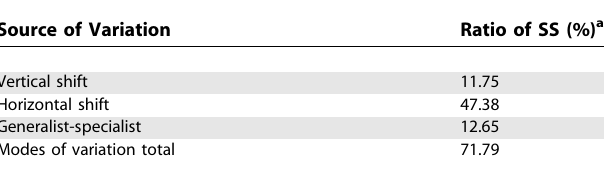
Table 1. Decomposition of Shape Variation Source of